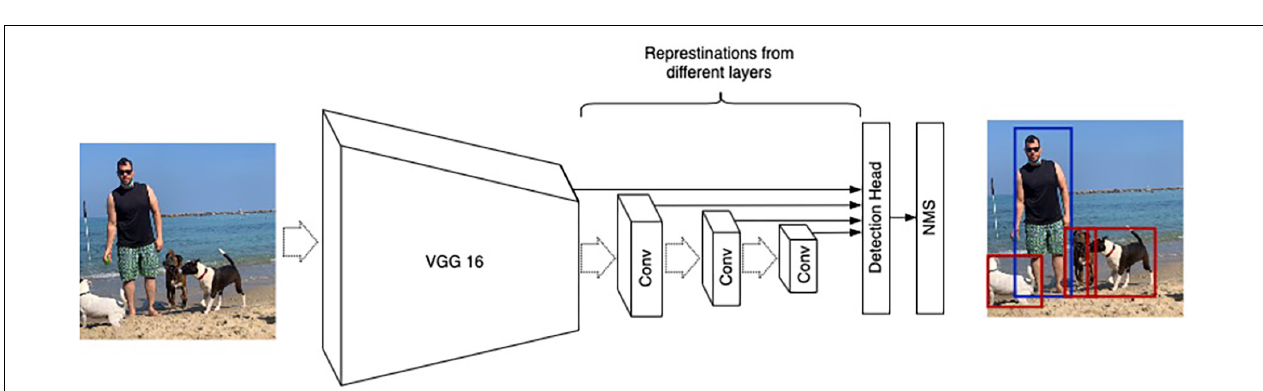
FIGURE 3 | Output of SSD trained on Pascal VOC. The algorithm detects and wraps the objects with bounding boxes as well as correctly classifying them into the relevant class (the classification is depicted by the bounding box color: red corresponds to “Person” class, blue to “Dog” class, yellow to “Car” class, and green to “Bicycle” class).